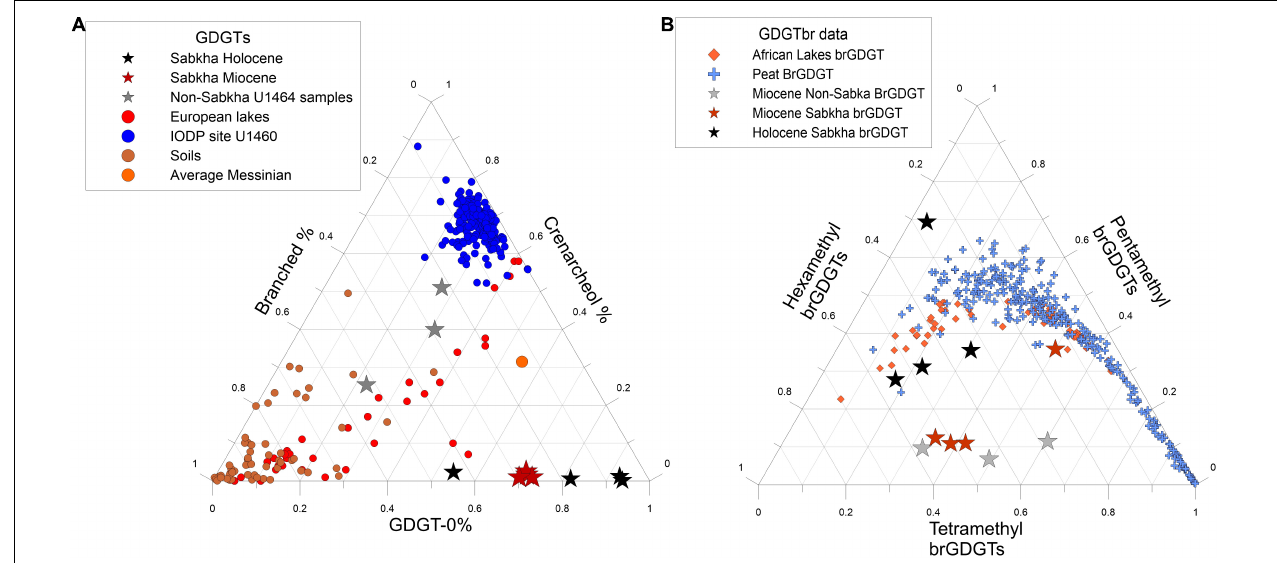
FIGURE 6 | Ternary plots showing the relationship between the various types of GDGTs. (A) Relative percentages of GDGTs in different environments. Data from: Pleistocene samples from IODP U1460, a site near by with a more oceanic signature (blue dots) (Petrick et al., 2019), European lakes (red dots) (Blaga et al., 2009), global soil sample compilation (brown dots) (Weijers et al., 2006). (B) Relative percentages of BrGDGTs in different environments including African lakes [orange diamonds (Russell et al., 2018)] and a global peat compilation [blue crosses (Naafs et al.,